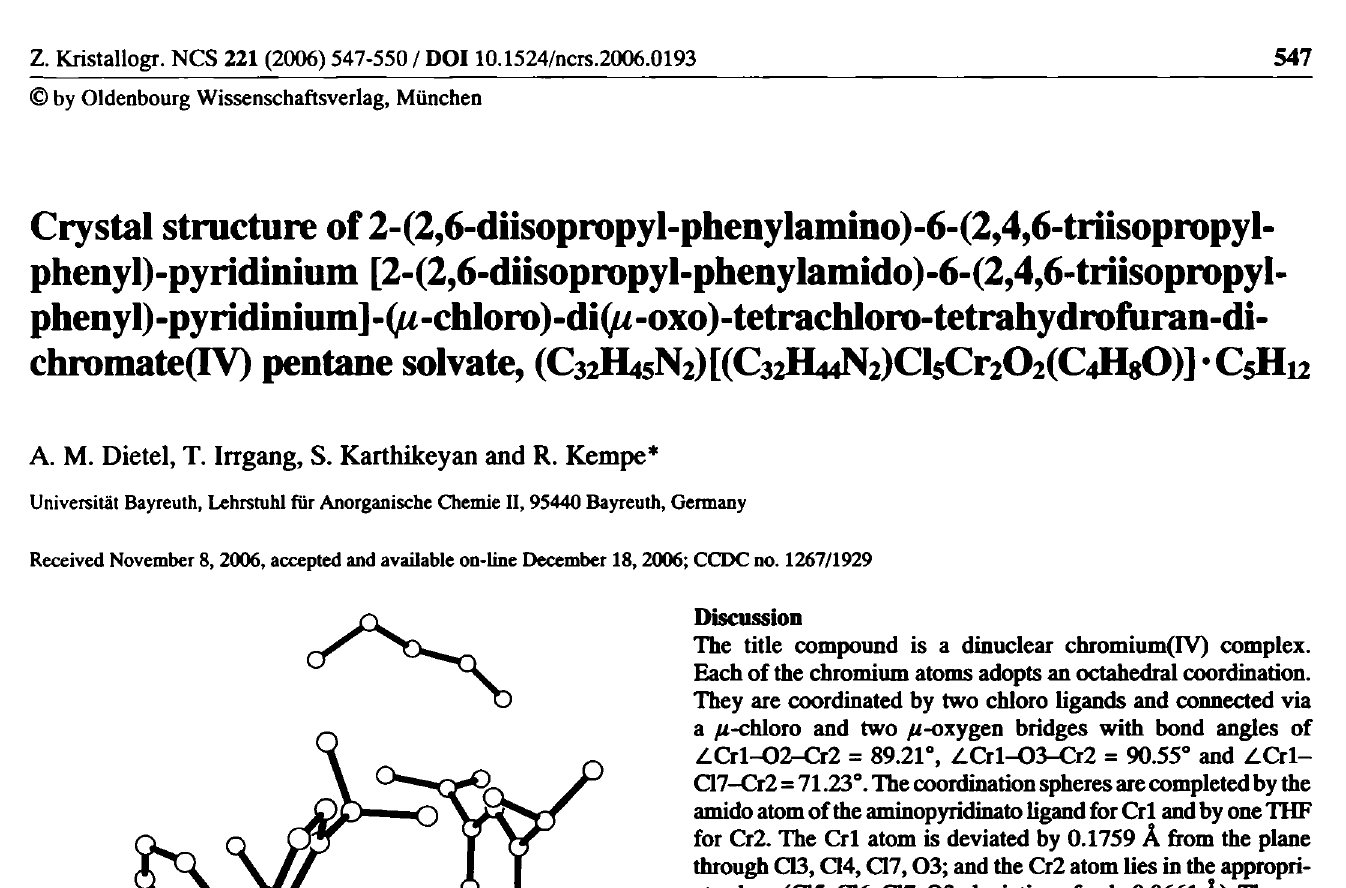
Table 1. Data collection and handling.